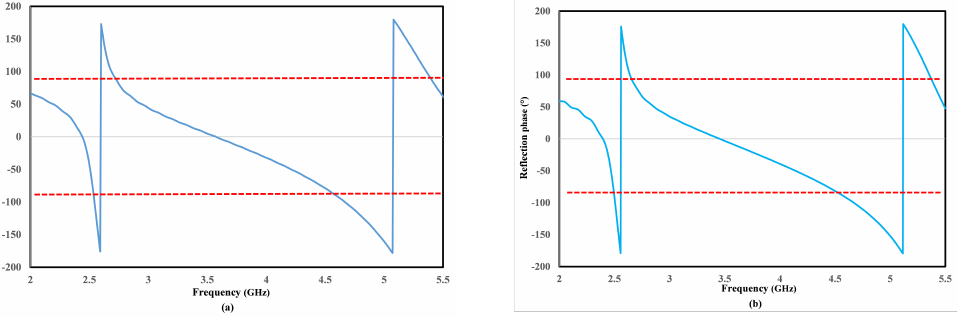
Figure 2. EBG unit cells. ( a ) Mushroom-like EBG unit cell. ( b ) Unit cell with plus-shaped slots.